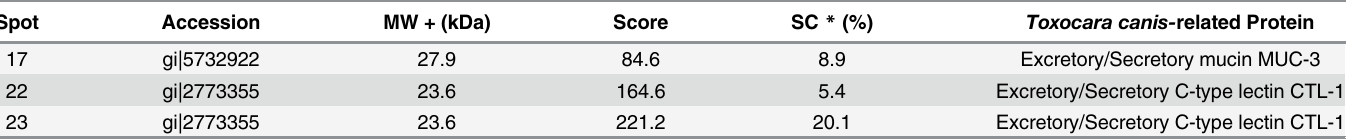
Table 1. Identified proteins from mass spectrometry